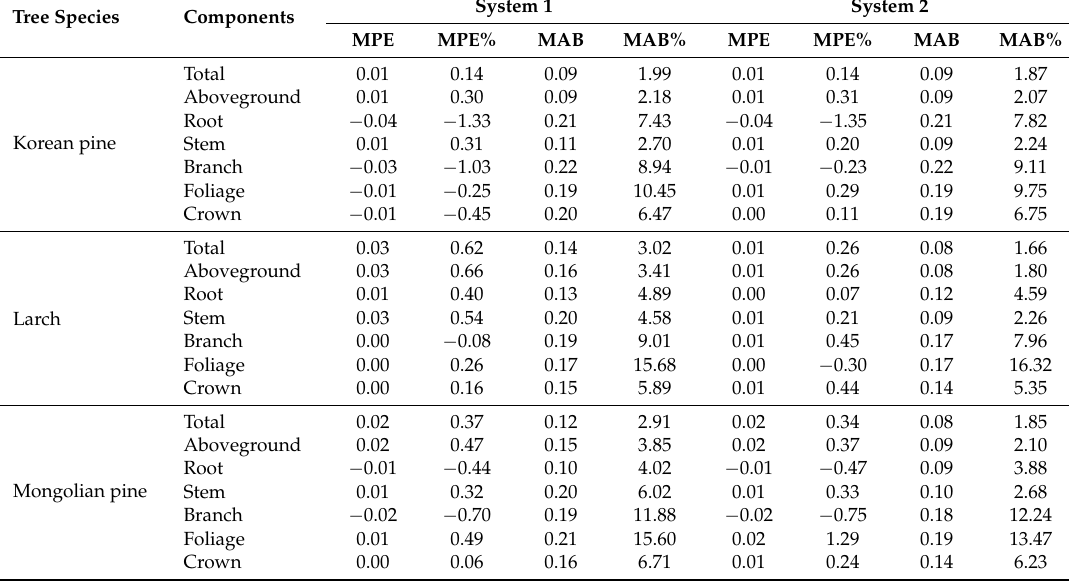
Table 5. Validation of log-transformed biomass equations by jackknifing technique. Tree